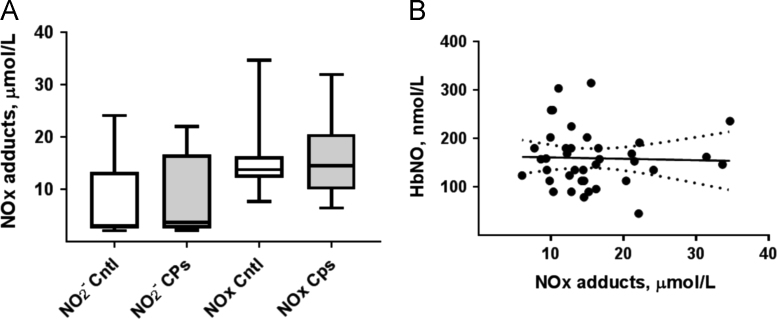
A. Concentrations of the nitric oxide oxidation products (nitrite and NOx) in plasma of control subjects and CP consumers measured by Griess reaction-based assay. Data are presented in box plot (median, 5–95 percentile; n=16 and 22 in control and CP groups respectively). B. Erythrocyte concentrations of HbNO measured by the EPR subtraction method versus plasma NOx concentrations in the same subjects (Linear regression analysis: R2=0.001; P=0.8; n=38).